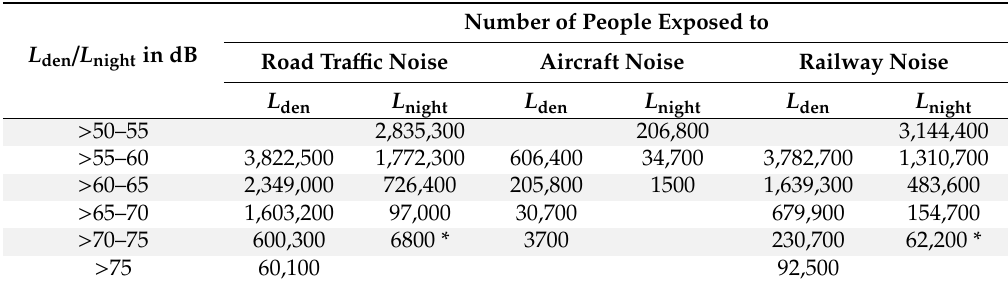
Table 3. Number of persons a ff ected by di ff erent tra ffi c noise sources in Germany in 2016.